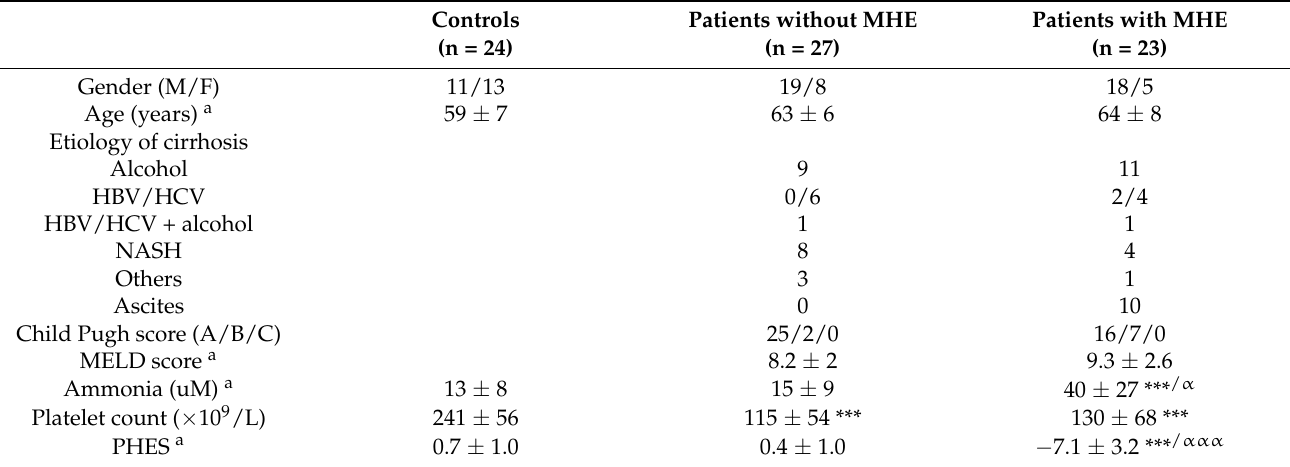
Table 1. The clinical and demographic variables of the